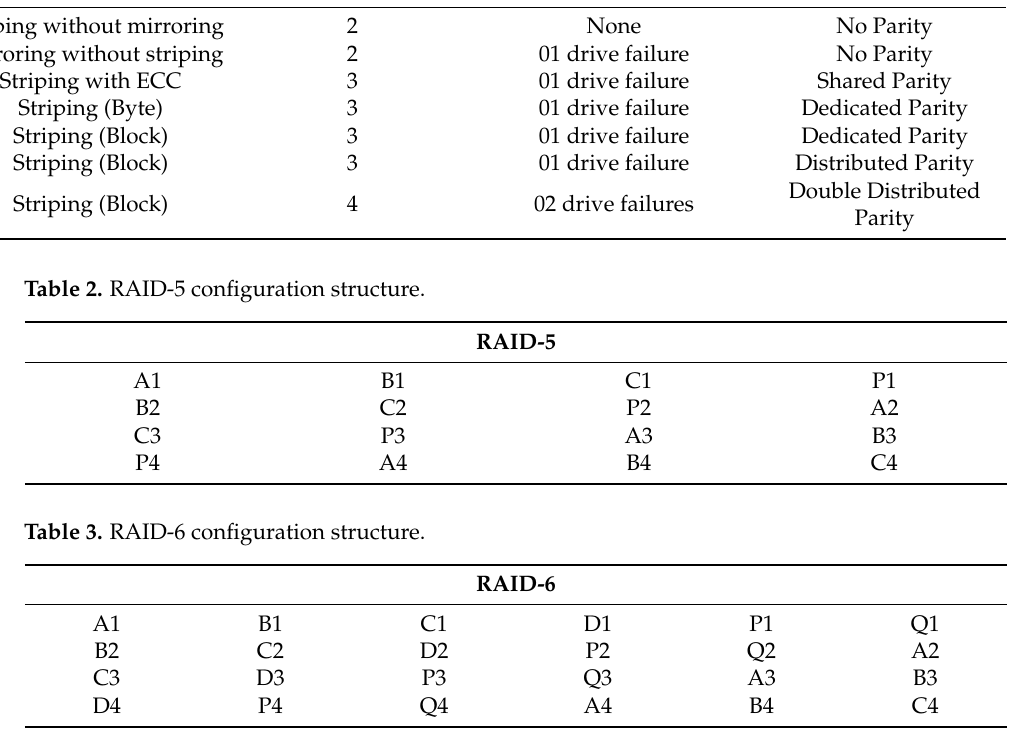
Table 4. Storage